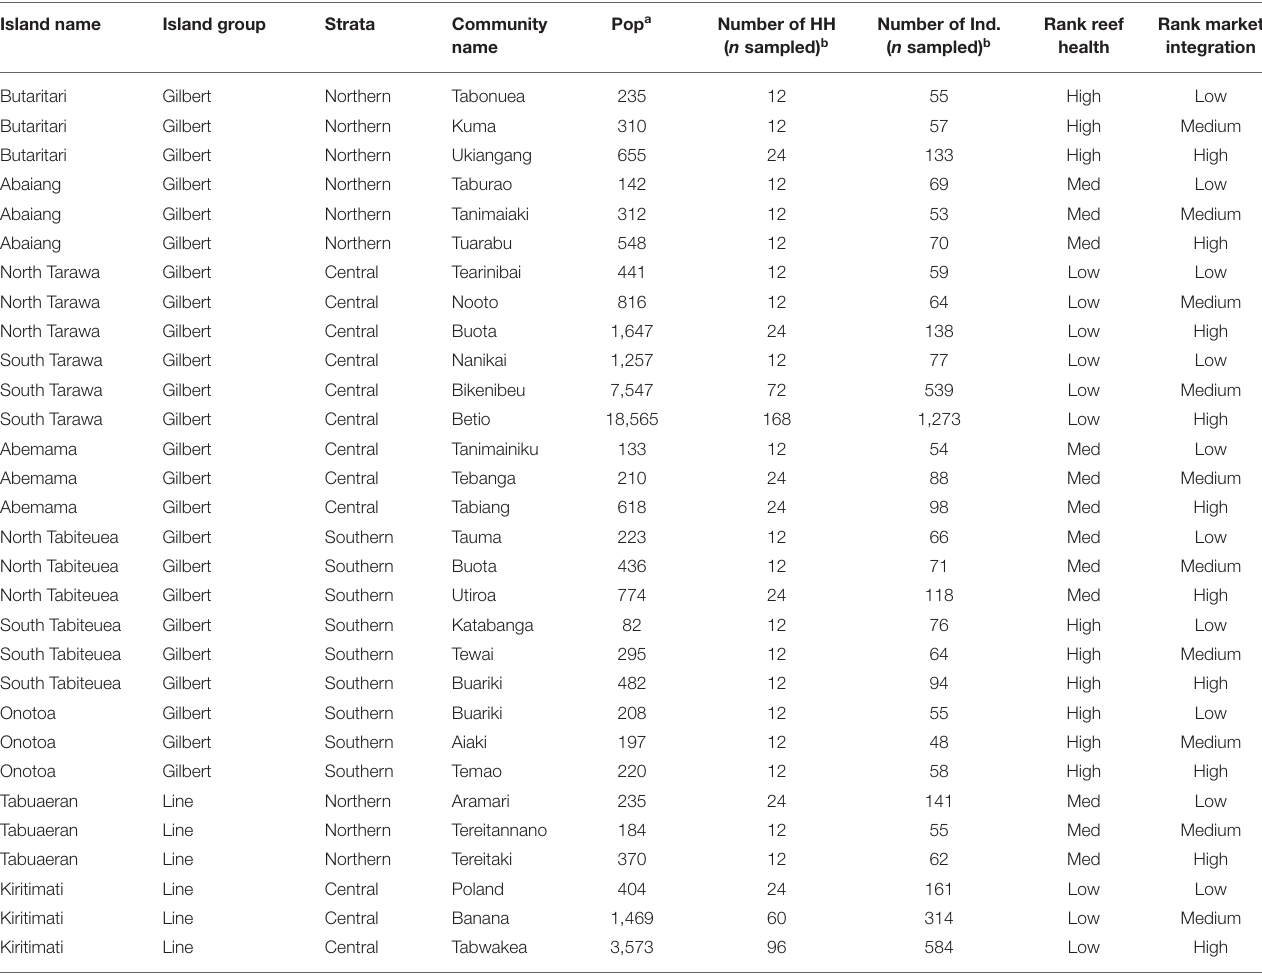
TABLE 1 | Study locations for the cross-sectional study in Kiribati with hypothesized reef health and market